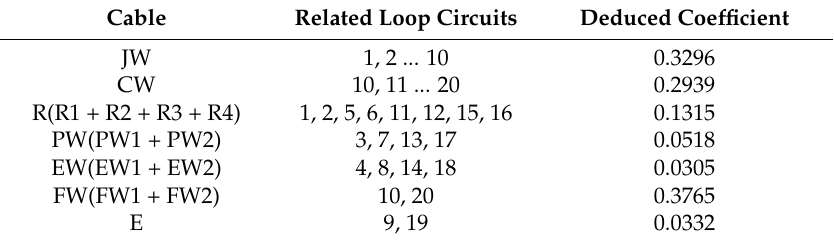
Table 4. Derived current distribution coefficients aimed at the short-circuit experiments.